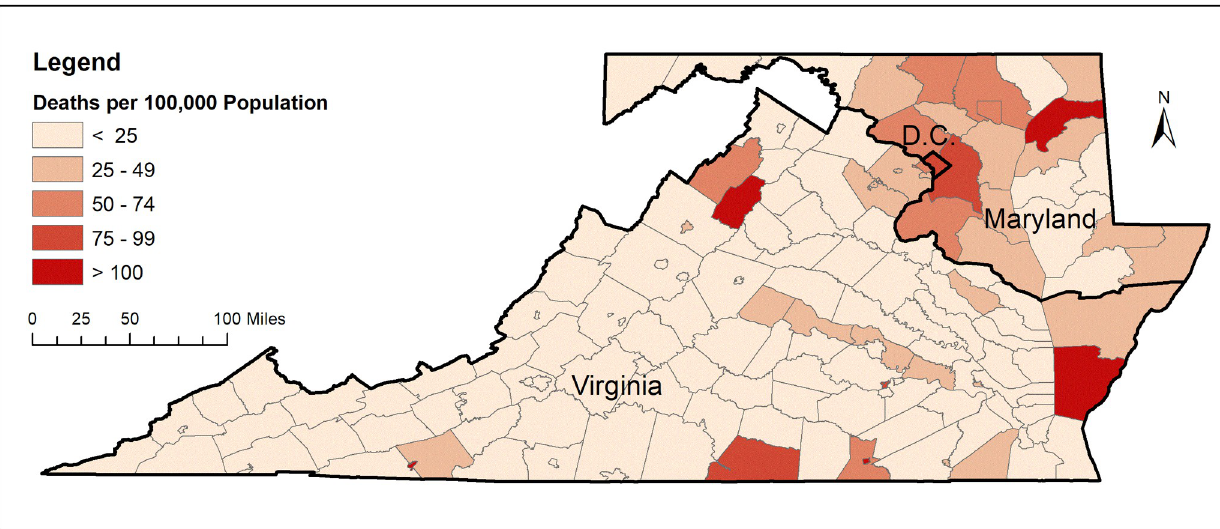
Fig 4. COVID-19 deaths per 100,000 population for counties within the DMV area. Source of data: COVID-19 Data Repository by the Center for Systems Science and Engineering at Johns Hopkins University [30]. Data by June 30,